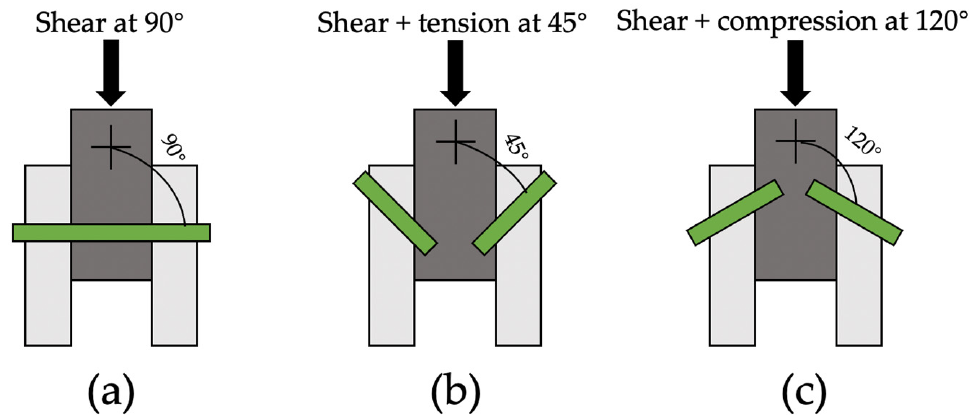
Figure 10. Schematic representation of different dowel insertion directions, and the type of load the dowels are subjected: ( a ) shear, ( b ) shear and tension in combination, and ( c ) shear and compression in combination. Redraw from [88] .